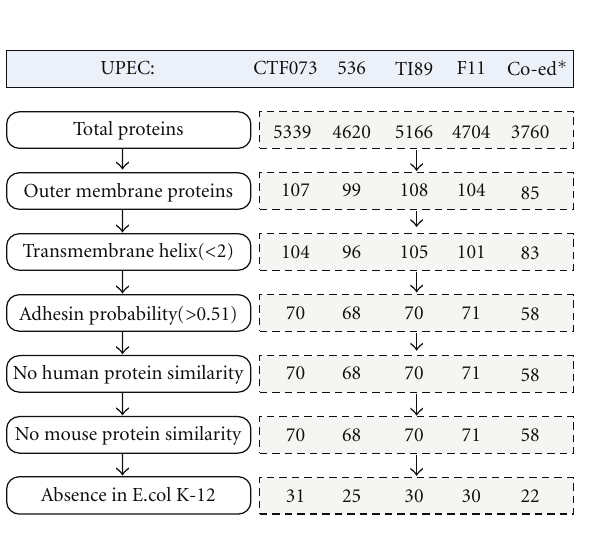
Figure 4: Prediction of UPEC vaccine targets conserved in four sequenced UPEC genomes using Vaxign. Note: ∗ Co-ed represents the conserved